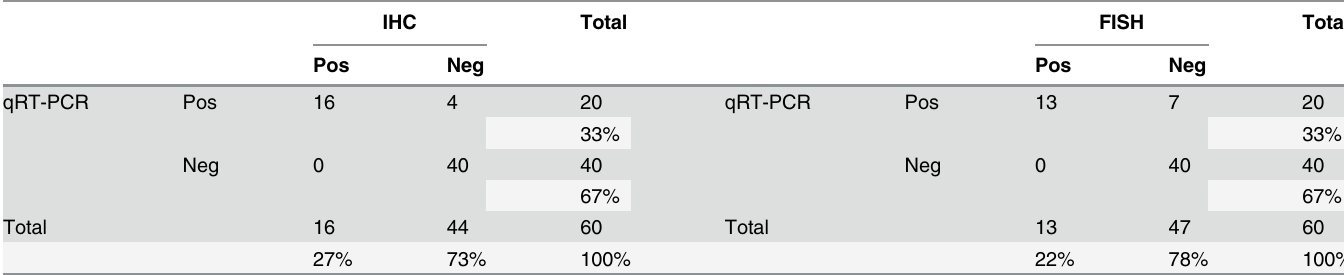
Table 3. Correlation of ROS1 qRT-PCR, IHC and